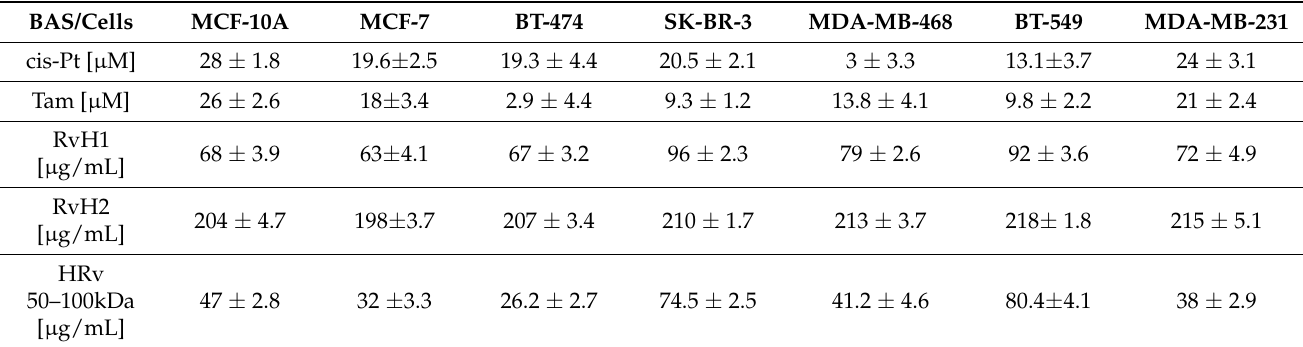
Table 2. IC 50 of BAS, isolated from R. venosa , tested on six breast cancer cell lines and the non- cancerous MCF-10A breast cell line. Widely used chemotherapy drugs cisplatin (cis-Pt) and tamoxifen (Tam) were used as positive controls.